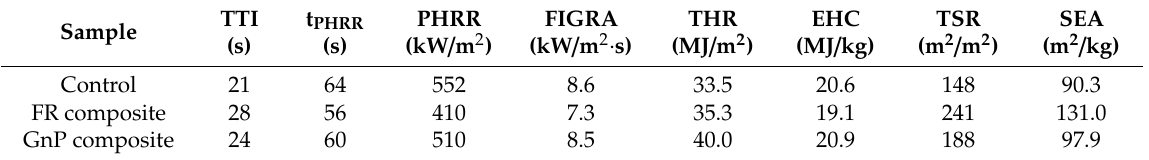
Table 3. The yields of gases evolved from the samples as determined by the FTIR. The data refers to